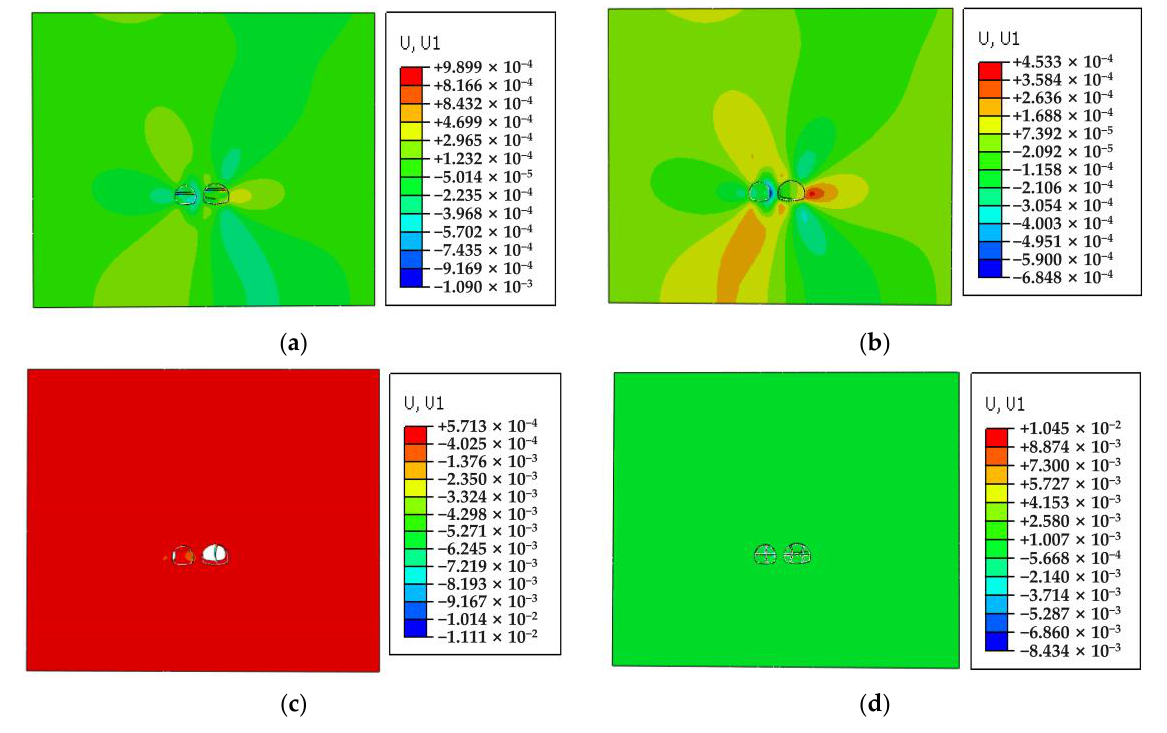
Figure 6. Overall horizontal displacement of surrounding rock (unit: m): ( a ) Step method; ( b ) Full section method; ( c ) CD method; ( d ) Double wall heading